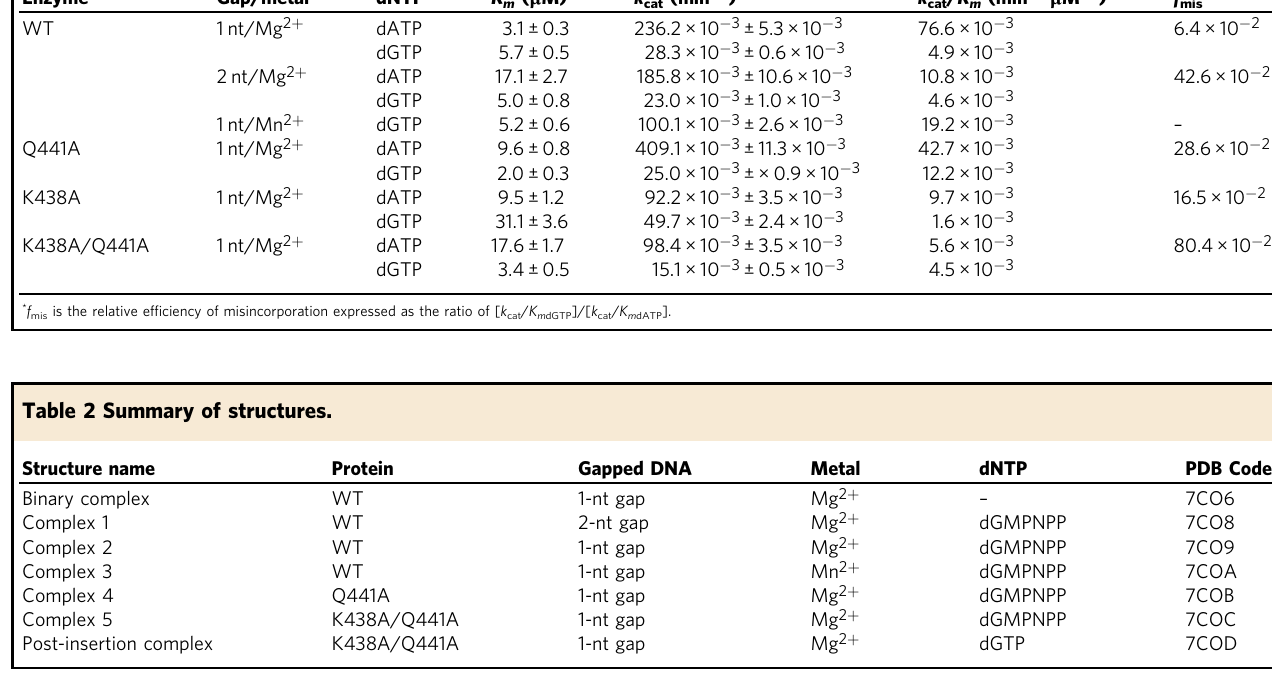
(dGMPNPP) opposite the templating T were solved. We deter- mined three types of structures for distinct Pol μ :DNA complexes (Table 2): (1) binary complex: WT crystallized with a 1-nt gapped DNA; (2) ternary complexes: WT with a 2-nt gapped DNA, dGMPNPP, and Mg 2 + (Complex 1); WT with a 1-nt gapped DNA, dGMPNPP, and Mg 2 + or Mn 2 + (Complexes 2 and 3); Q441A single- and Q441A/K438A double-mutant proteins with a 1-nt gapped DNA, dGMPNPP, and Mg 2 + (Complexes 4 and 5); and (3) post-insertion complex: Q441A/K438A mutant protein with a 1-nt gapped DNA and soaked with dGTP/Mg 2 + . All seven Pol μ complexes crystallized in the P 2 1 2 1 2 1 space group with one